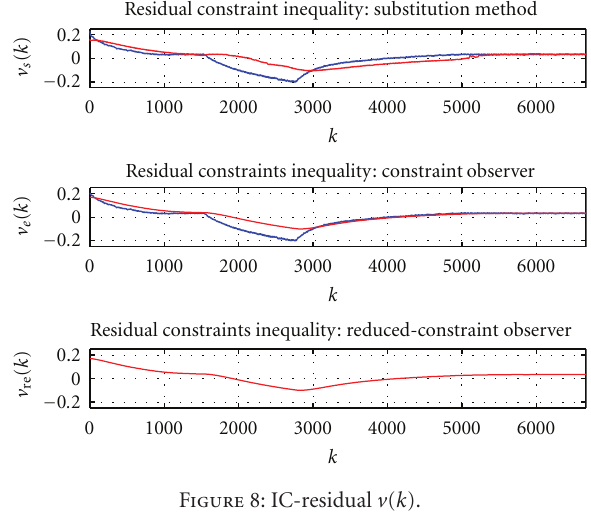
Figure 8: IC-residual v ( k